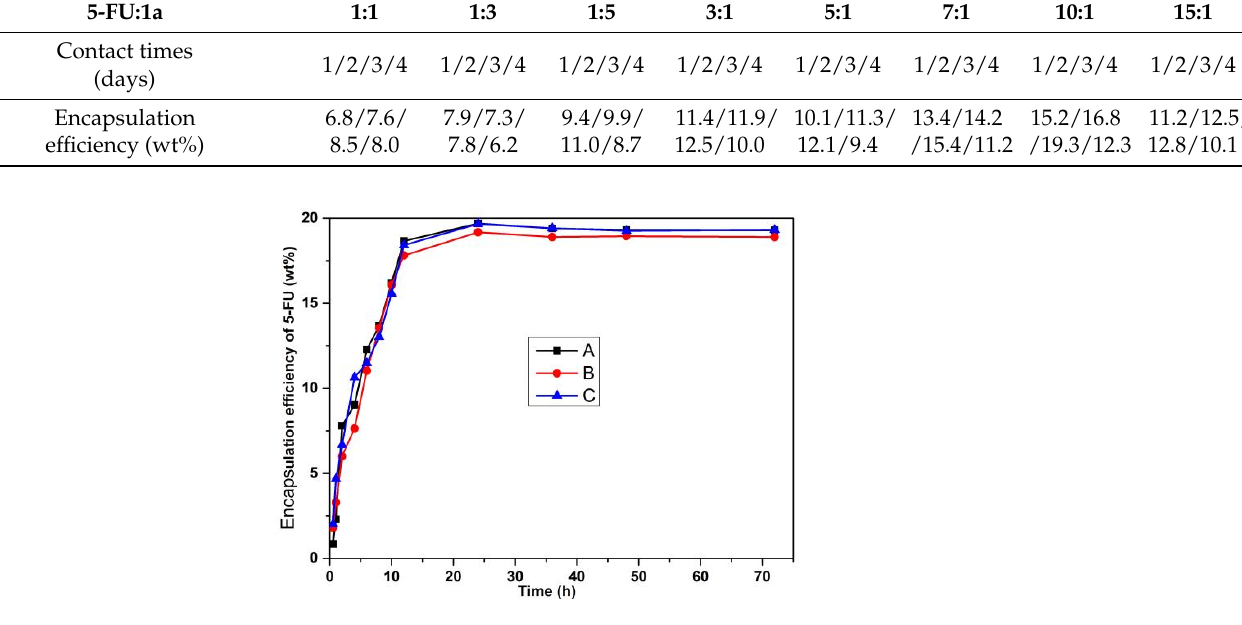
Figure 7. The encapsulation efficiency of 5-FU for different times under the 10:1 condition. The 5-FU@ 1a obtained by loading for 24 h at a mass ratio of 10:1 was added to a conical flask containing 50 mL PBS, allowed to release for 120 h, and 0.1 mL of the solution was pipetted with a pipette at 0, 1, 2, 4, 6, 8, 10, 12, 24, 36, 48, 72, 96, and 120 h in a 10 mL volumetric flask and dispensed to the scale line and left for 5 min before the absorbance was measured by UV spectrophotometer. At the same time, an equal amount of PBS was added to the conical flask, and the concentration of 5-FU after release was calculated according to the linear regression equation with PBS as the solvent, and the release rate of 5-FU was further calculated. As shown in Figure 8, the cumulative release rate was 40.26% at 12 h and 70.05% at 120 h, indicating that 5-FU@ 1a has a slow release performance. Within 20 h, no “burst effect” was observed, while 70% of the 5-FU drug molecules were released after 120 h. There are two different stages of 5-FU release: 40.26% (0–14 h) for the first stage and 29.79% (14–120 h) for the last stage. Drug molecules may be released due to the concentration differences between the dialysis bag and the PBS solution.